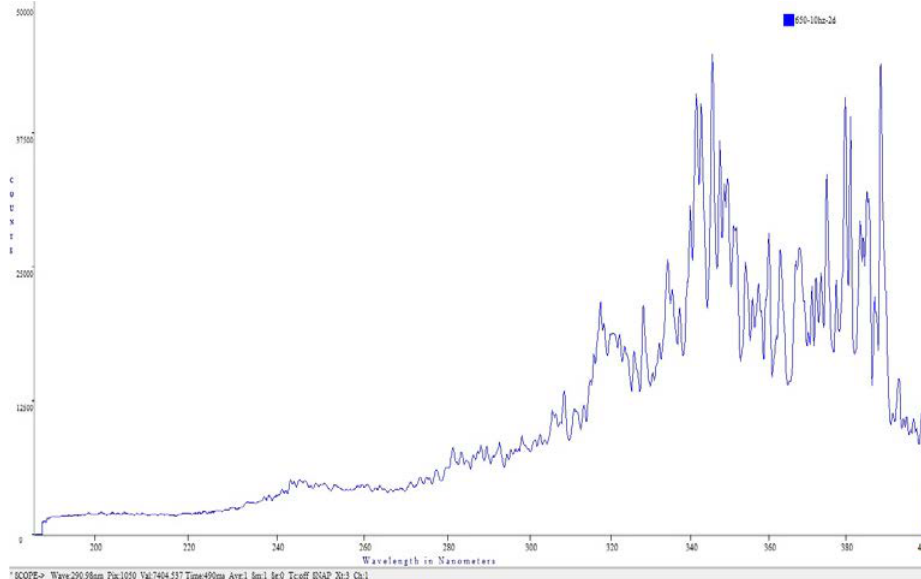
Fig.9: Emission spectra of laser energy 650 mJ with (10Hz ) repetition rate.